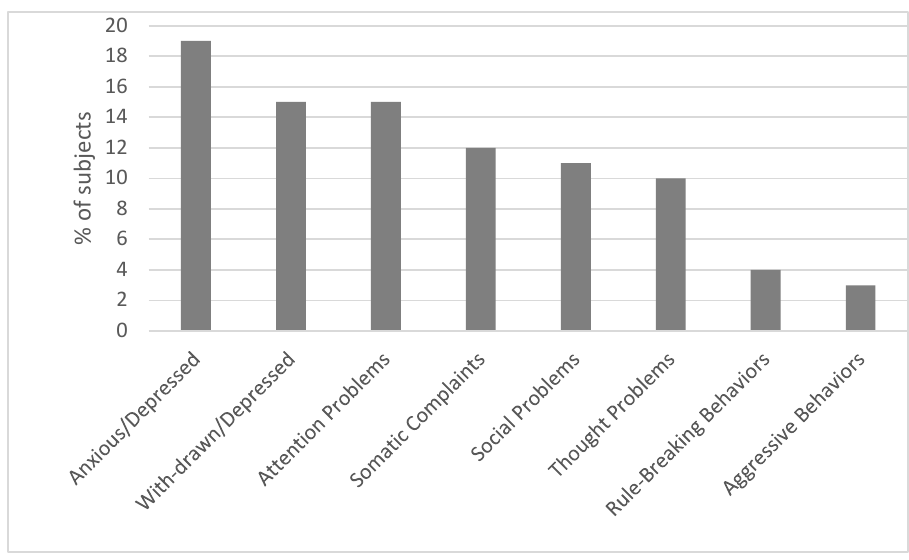
Figure 2. % of scores in the borderline (64 – 69) or clinical (>70) range at the syndrome subscales. A significant difference across the DSM-oriented sub-scales emerged (F(4, 468) = 27.20, p < 0.001), with a large effect-size (Partial Eta Squared = 0.18). Post-hoc comparisons